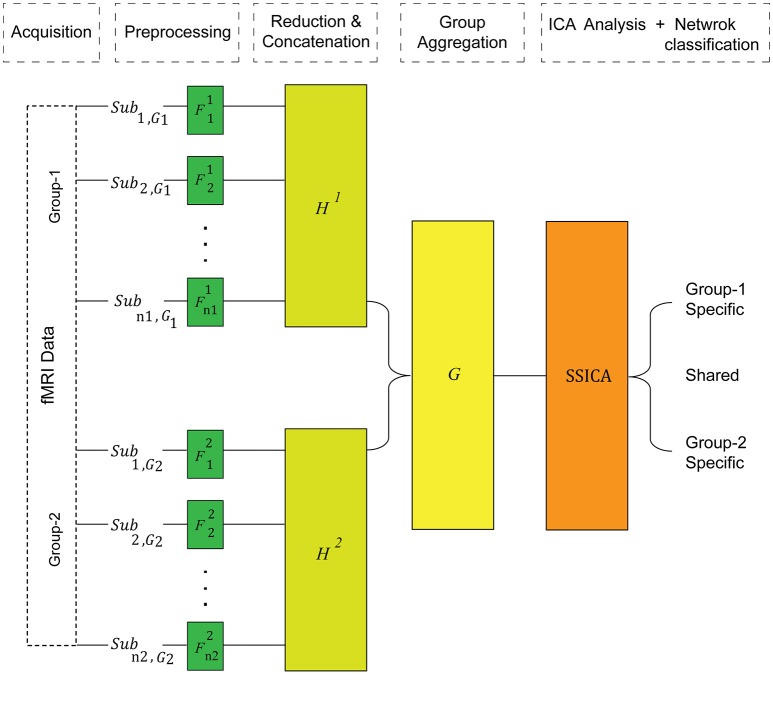
The SSICA algorithm schematic. There are three levels of data whitening and dimension reduction in SSICA. F, H, and G represent the projection matrices at the first (subject), second (within-group), and the third (between-group) levels of data reduction, respectively.